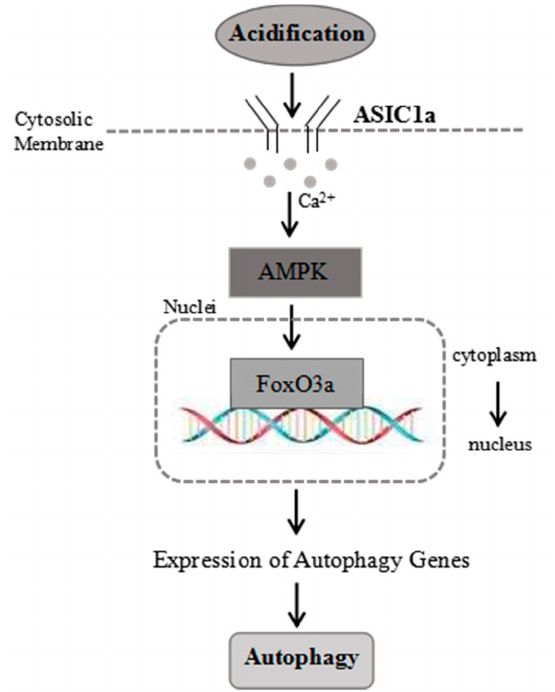
Figure 7. Proposed model for the role of AMPK/FoxO3a signaling in the ASIC1a-mediated autophagy in rat articular chondrocytes.